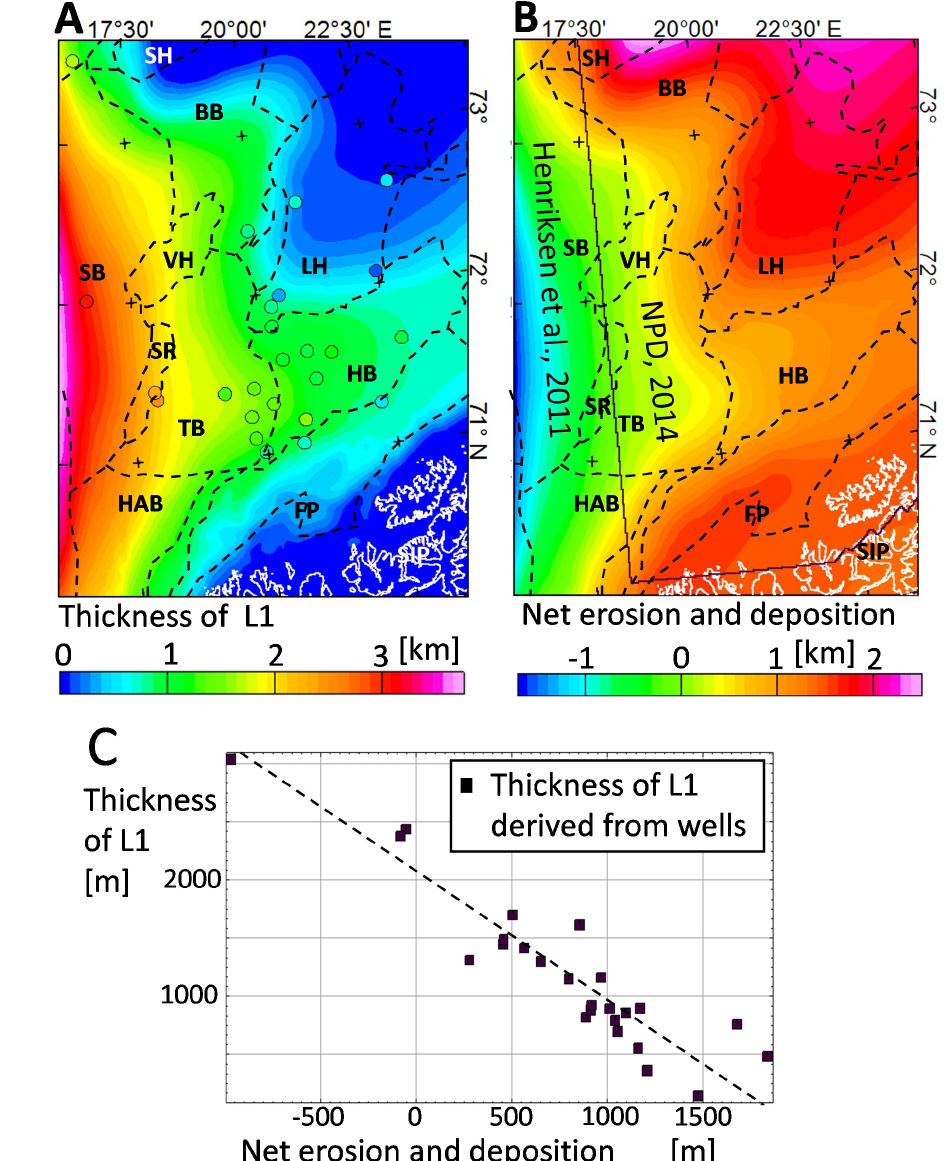
Figure 5. (A) Thickness of sedimentary unit L1 with thicknesses derived from density well logs, shown by the coloured fill of the circles at the well locations. (B) Net erosion and deposition compiled from the maps of the Norwegian Petroleum Directorate (Norwegian Petroleum Directorate, 2014) and of Henriksen et al. (2011). Boundaries of structural elements (black dashed, details in Fig. 1, abbreviations in Fig. 2). (C) Cross plot of well-derived thicknesses of unit L1 vs. net erosion and deposition with calculated linear regression line (dashed; slope = 1.0533, intercept = 2019.7